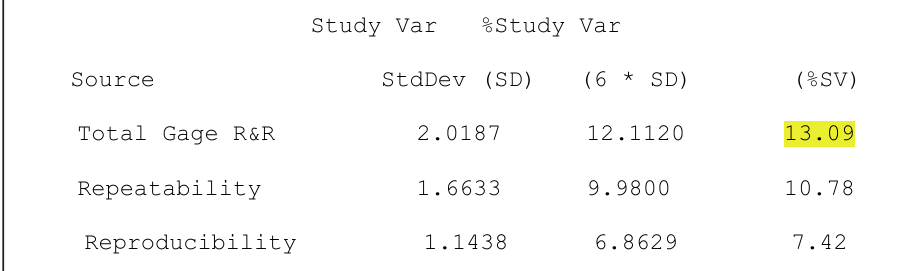
Two-Way ANOVA Table with Interaction (Process Industry) Gauge